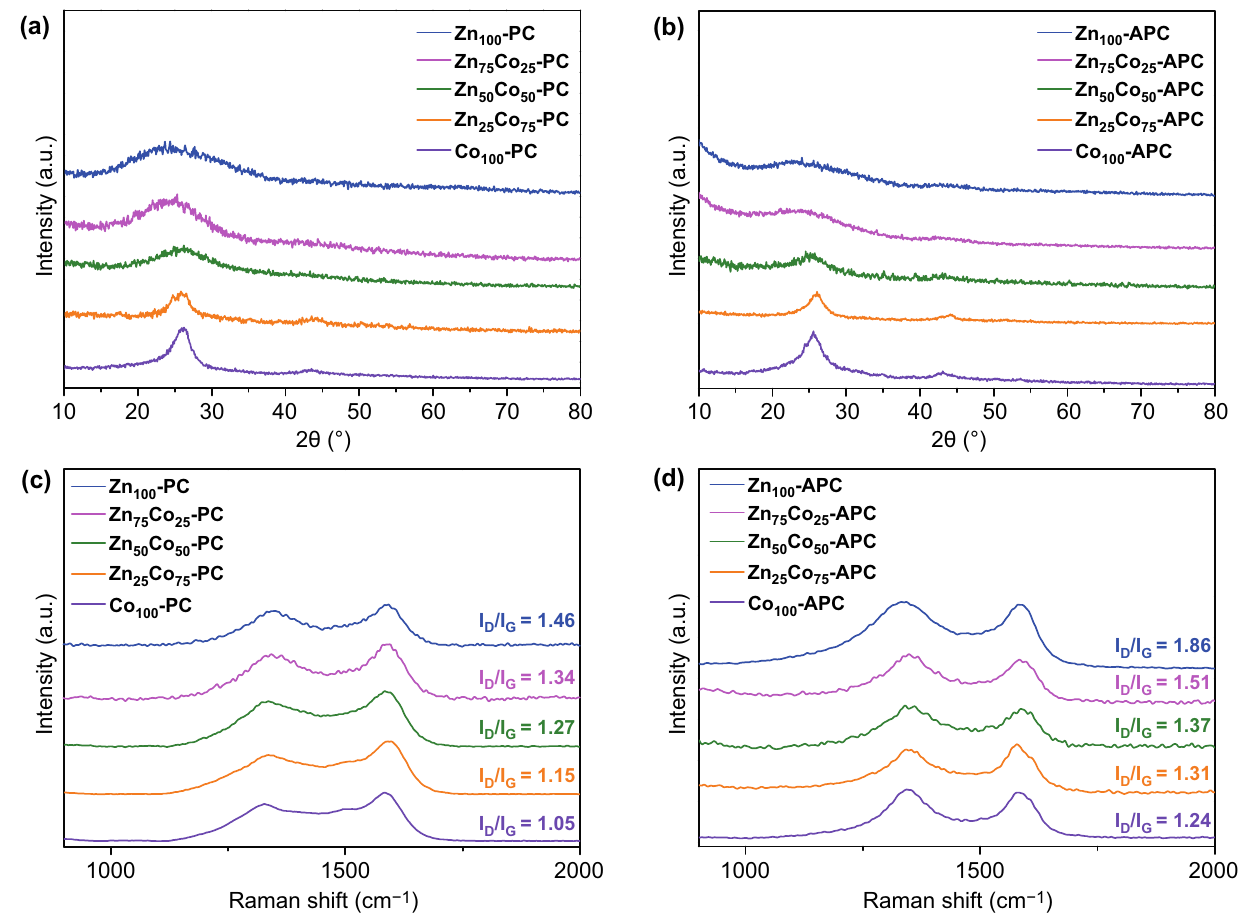
Fig. 1 The XRD patterns and Raman spectra of a , b Zn x Co 100− x PCs and c , d Zn x Co 100− x